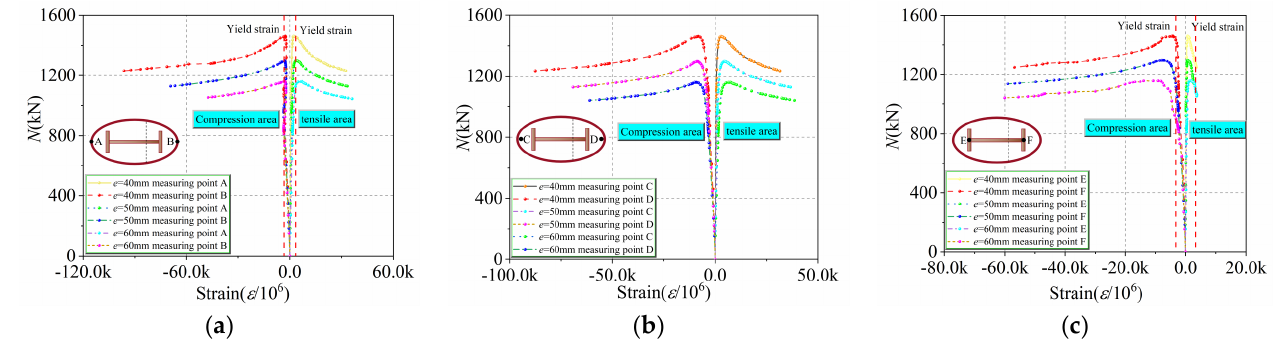
Figure 15. N – ε curves for various eccentricities: ( a ) steel tube; ( b ) concrete; ( c ) H−shape steel.